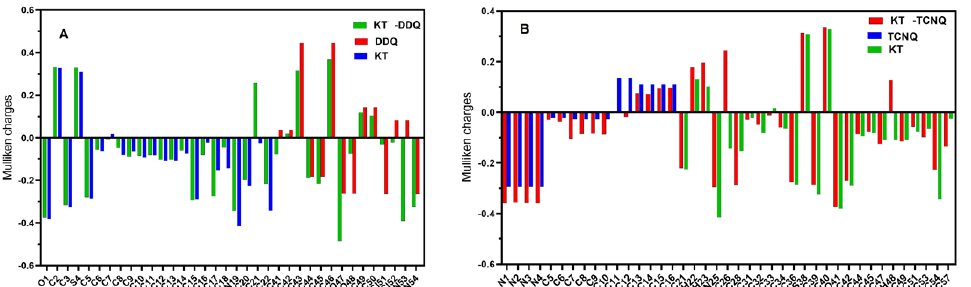
Figure 5. ( A ) The Mulliken charge and natural atomic charge distribution of the (KT–DDQ) complex and ( B ) the Mulliken charge and natural atomic charge distribution of the (KT–TCNQ) complex by the DFT/MPW1PW91 methods with a 6-311G(d, p) basis set.